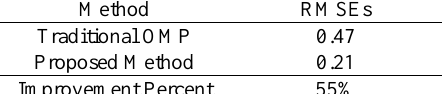
Table (3). The RMSEs of estimating the abundances of agricultural product